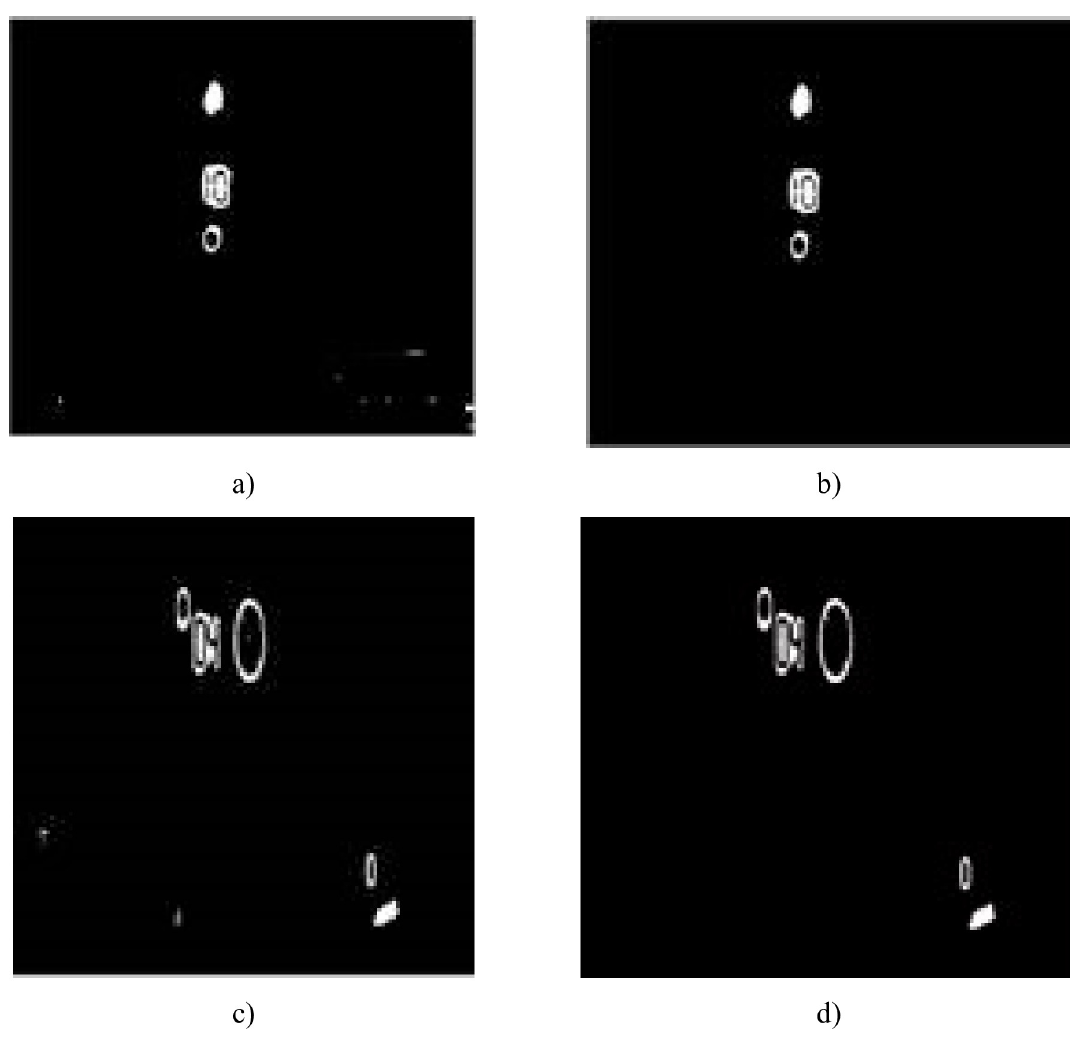
Fig 7. Comparison images before and after